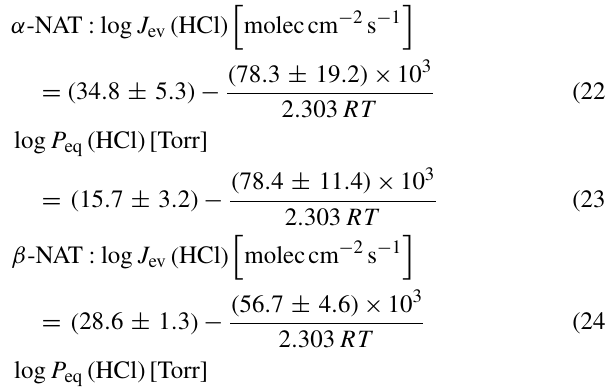
gas. Full red circles and black triangles represent the interac- tion of HCl with α - and β -NAT films,